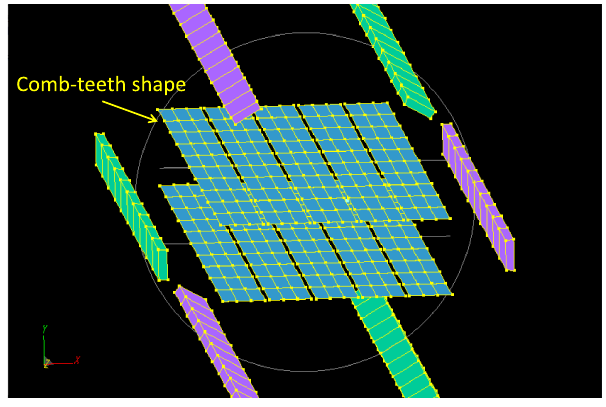
FIG. 9. Longitudinal slit model used to simulate the comb- tooth